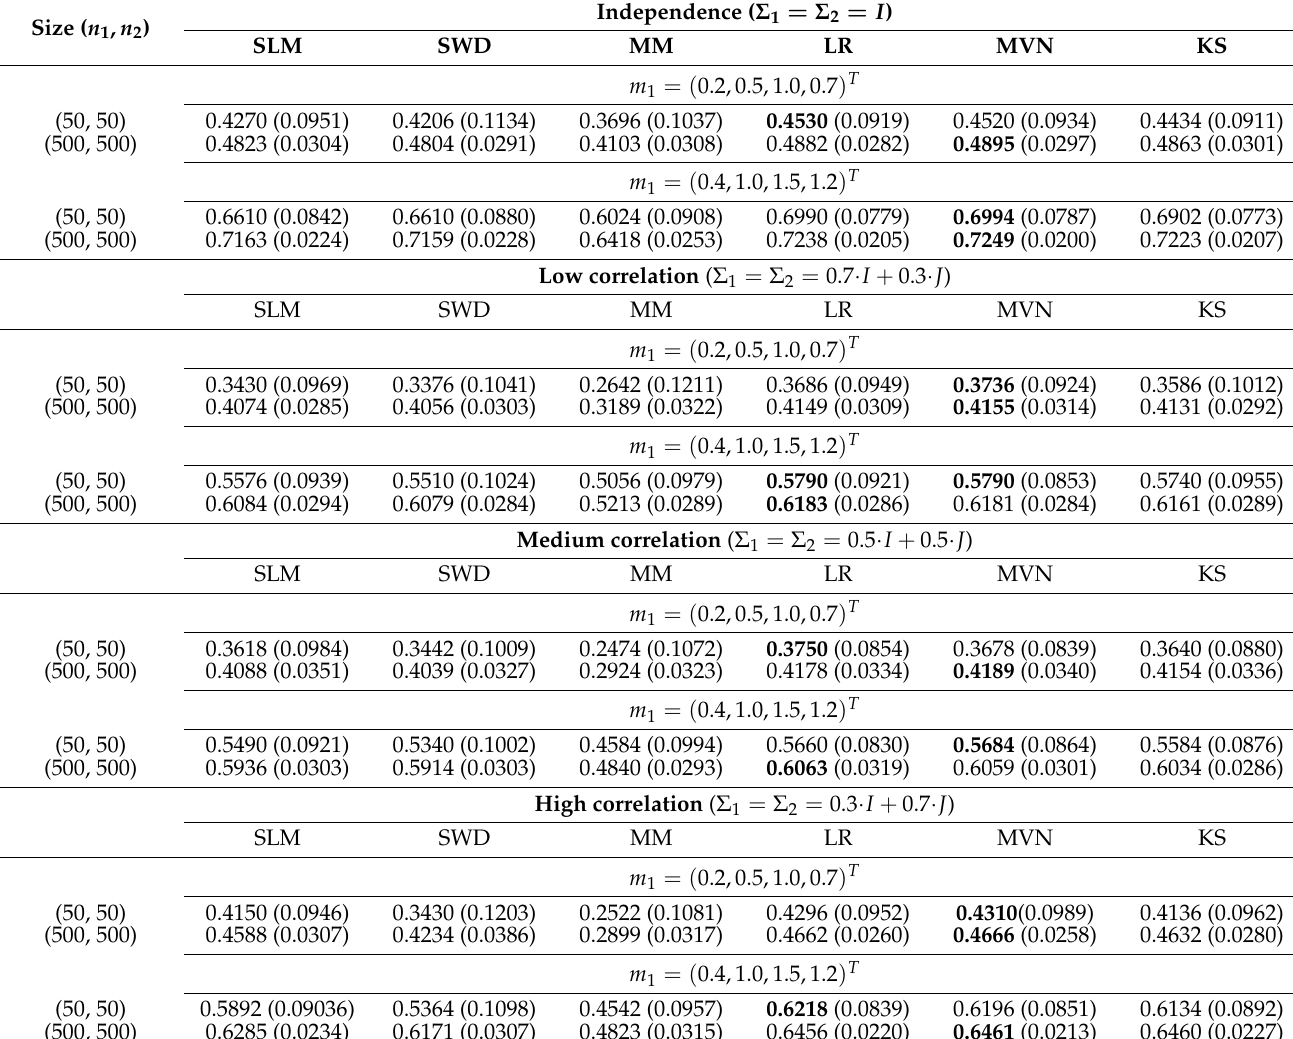
Table 11. Normal distributions: Different means and equal positive correlations. Validation.